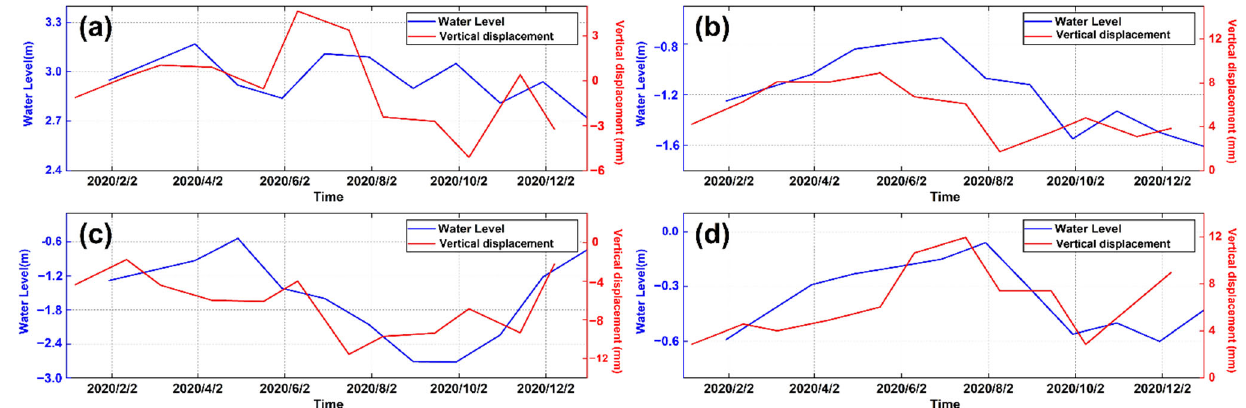
Figure 9. Comparison of groundwater level and average cumulative deformation variables. ( a – d ) are the changes of groundwater level wells a ‐ d respectively.